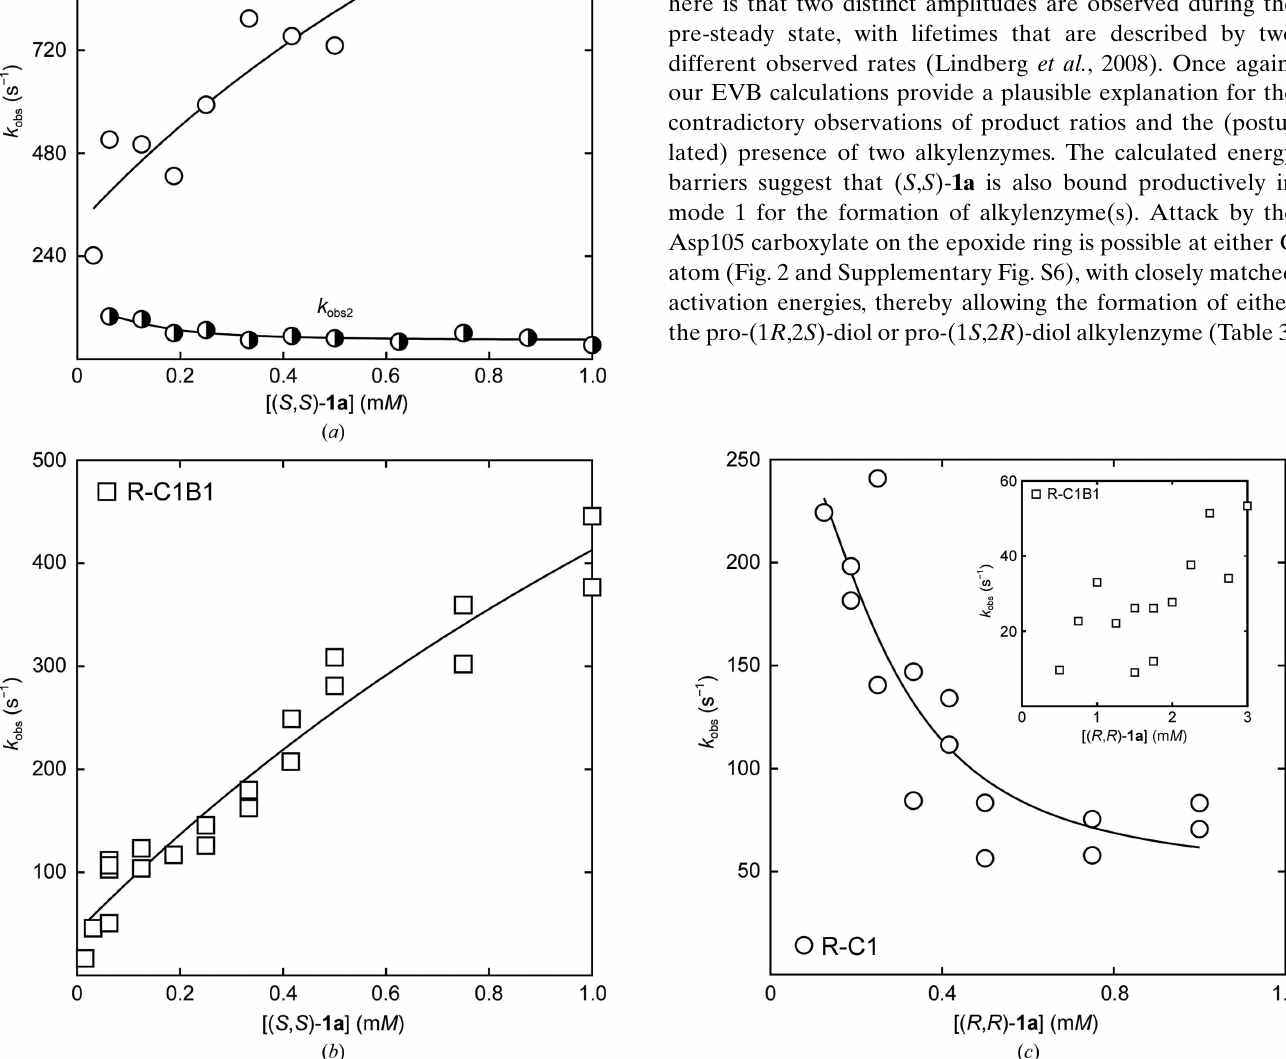
Figure 6 Example curve-fitting of the observed transient rates of alkylenzyme formation and decay. ( a , b ) The substrate-dependence of the observed transient rates, k obs , in the hydrolysis of ( S , S )- 1a catalyzed by ( a ) R-C1 and ( b ) R-C1B1. In the case of R-C1, the obtained fluorescence traces were fitted to a second-order exponential (3) to yield two observed rates (unfilled and half-filled circles, respectively), while the R-C1B1-catalyzed rates could be fitted to a first-order exponential (2). The substrate-dependencies of the respective k obs values were fitted to (4) in the cases of a hyperbolic dependency [unfilled symbols in ( a ) and ( b )] and to (5) in the case of a decreasing k obs with an increasing concentration of substrate [half-filled symbols in ( a )]. ( c ) The substrate-dependence of the observed transient rates, k obs , in the hydrolysis of ( R , R )- 1a catalyzed by R-C1 and R-C1B1 (inset). The observed concentration-dependency in the R-C1B1-catalyzed reaction was inconclusive and no fitting was performed. In the case of R-C1, the obtained k obs values were fitted to (5). See x 2 for